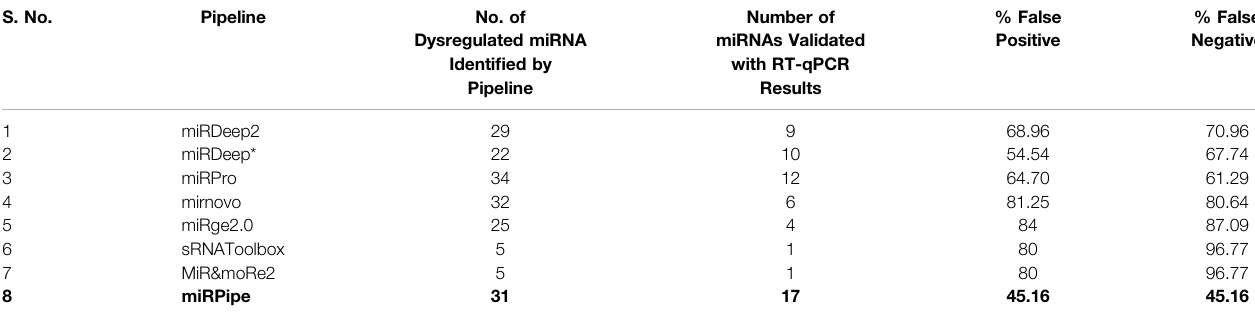
TABLE 4 | Comparison of pipeline performance in CLL real RNA-Seq expression dataset. S. No.